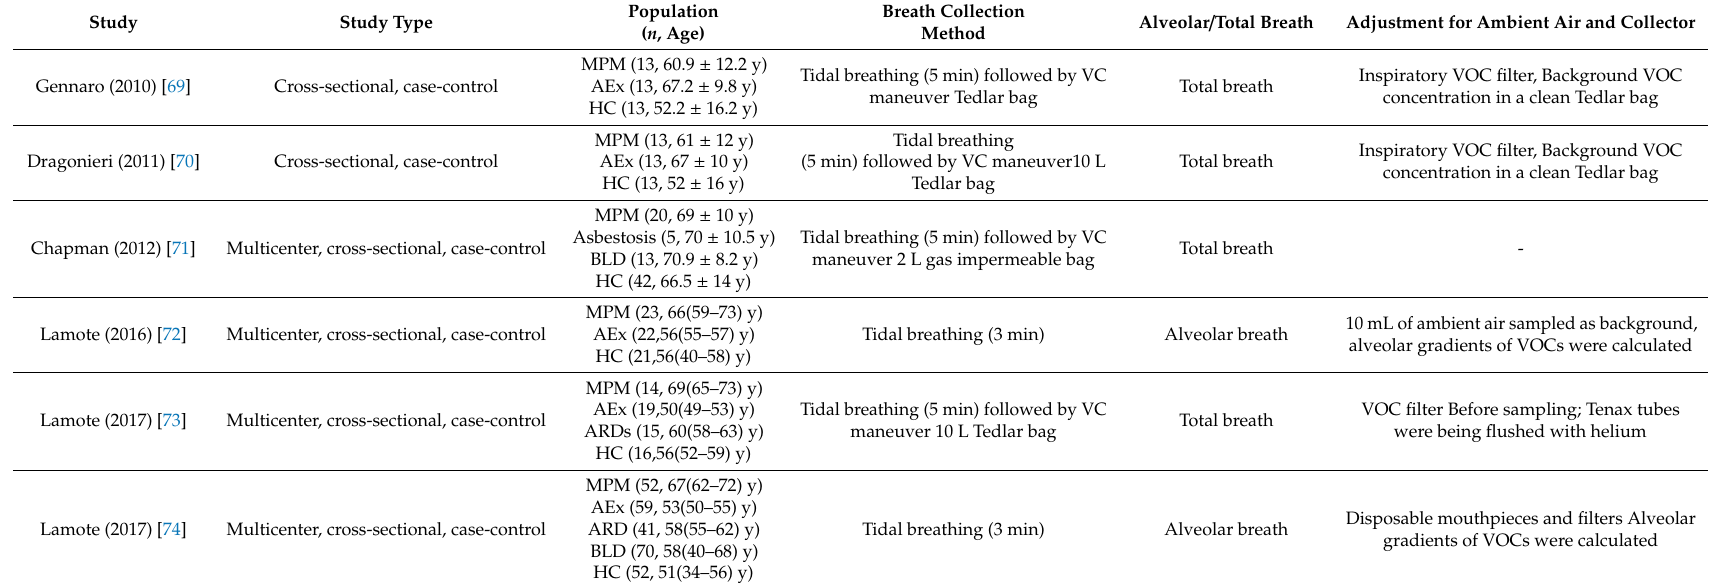
Table 3. Overview of the studies regarding study type and the exhaled breath sampling